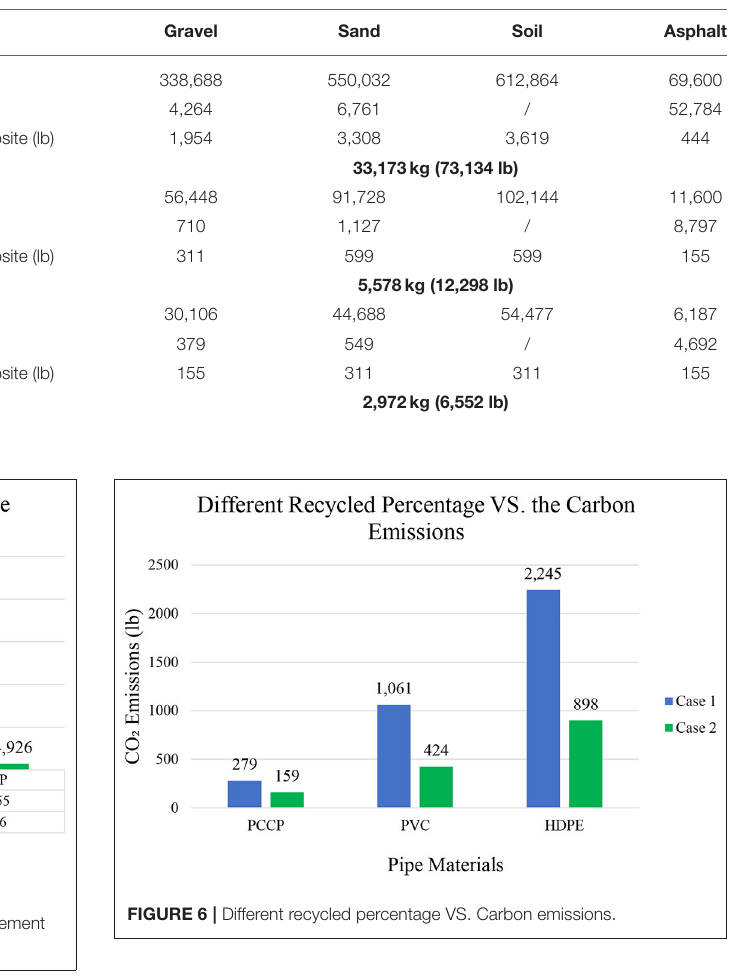
TABLE 4 | CO 2 Emissions from Backfill Materials.